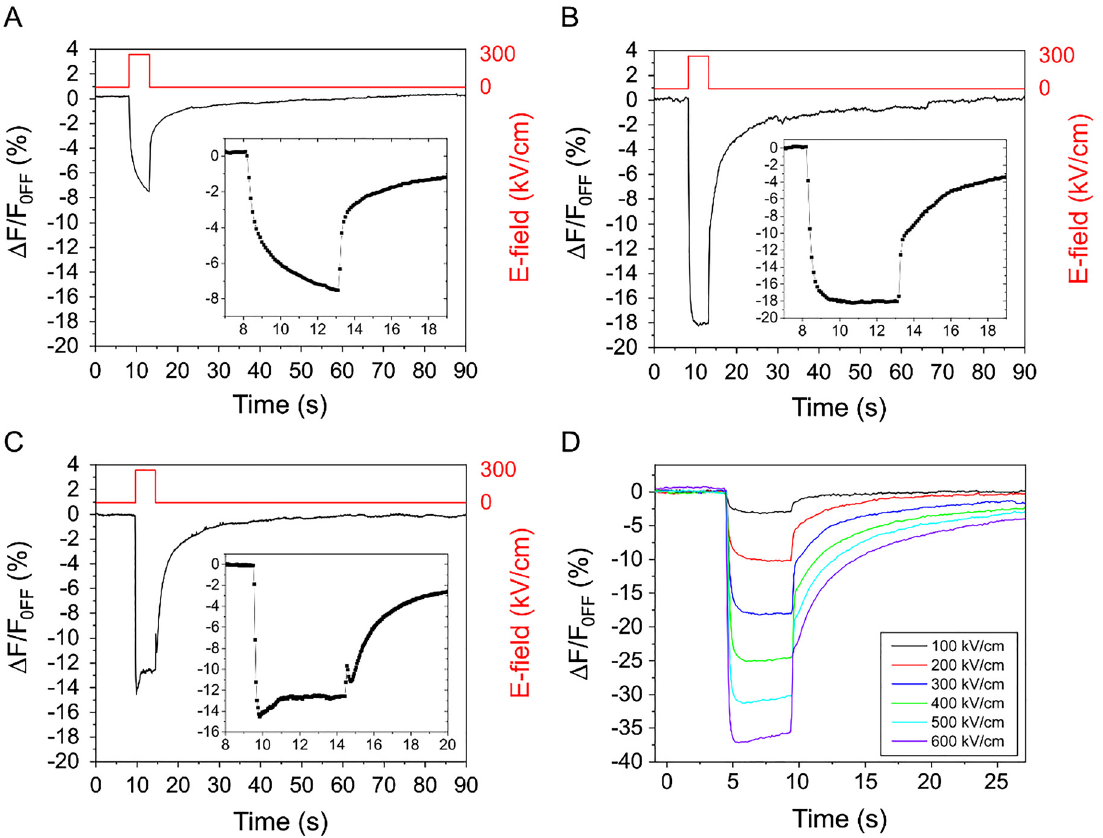
Figure4: Temporalbehaviorofthe1Pexcitation Δ F / F OFF foranapplied fi eldof(300 ± 5)kV/cmfor(A)thetype-IQD6-PSMA,(B)thequasi-type-II QD9-PSMA and (C) the quasi-type-II QR35-PSMA; (D) Δ F / F OFF transients of the quasi-type-II QD9-PSMA for a range of electric fi eld